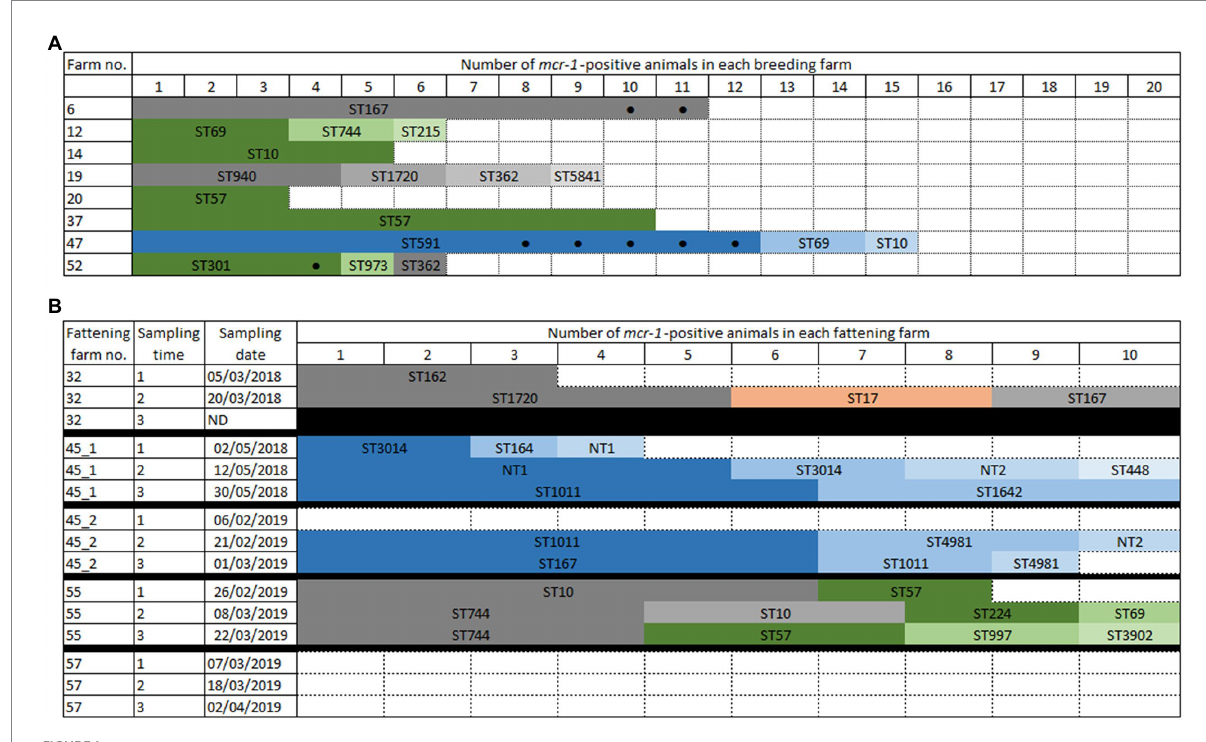
FIGURE 1 Schematic representation of mcr-1 -positive Escherichia coli in breeding (A) or fattening (B) farms. The mcr-1 gene was found on IncX4 (blue colors) or IncHI2 (green colors) plasmids, or on the chromosome (grey colors). (A) Each colored box represents a mcr-1 -positive goat. All boxes correspond to kids, except those marked by a black dot. Empty boxes indicate that no colistin-resistant isolate found. (B) In ST17 (orange color), mcr-1 could not be located. Black boxes indicate that the time point was not sampled. Empty boxes indicate that no colistin-resistant isolate found.